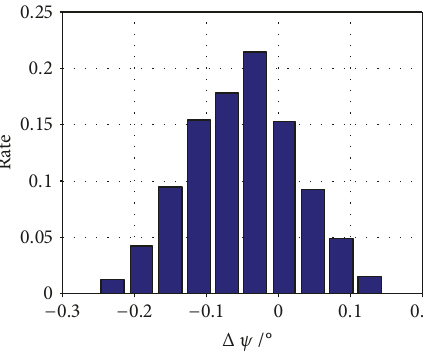
Figure 15: Distribution of heading angle error.